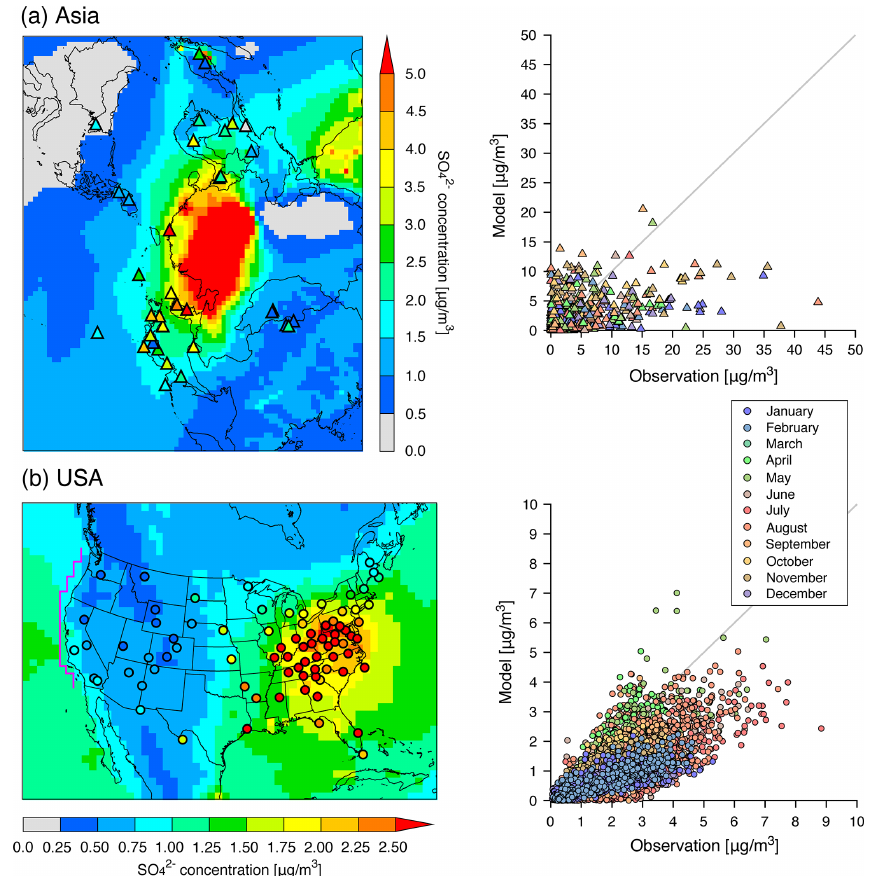
Figure 4. Simulated annual averaged SO 2 − concentration in 2010 by original H-CMAQ over (a) Asia and (b) USA with overlaid EANET 4 and CASTNET surface observations. Scatterplots between surface observation (EANET over Asia, and CASTNET over USA) and original H-CMAQ with identification colors for each month are also shown. Note that the color scale is different for Asia and USA. The pink line over the western USA in (b) is the defined as the western edge to analyze the vertical profile of SO 2 − concentrations (see Fig. 4